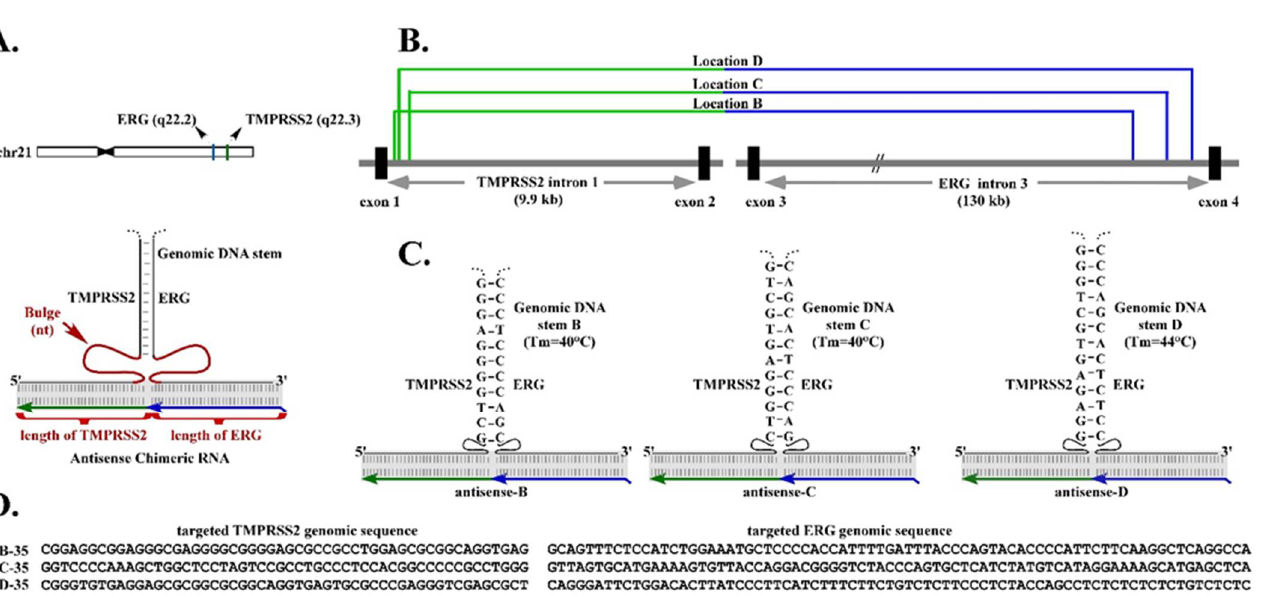
Figure 1. A model of three-way junction formation in RNA-mediated TMPRSS2-ERG gene fusion. ( A ) Upper panel: chromosomal locations of TMPRSS2 and ERG genes. Both TMPRSS2 and ERG genes are on the minus strand of chromosome 21, separated by 3 Mb, an intra-chromosomal configuration prone to rearrangements. Lower panel: schematic illustration of a three-way junction formed between genomic DNA and chimeric RNA. The three-way junction model consists of the RNA/DNA duplex and the intergenic DNA stem formed by the genomic TMPRSS2 sequence complementary to the genomic ERG sequence. Our study highlights the effects of two essential elements in the proposed three-way junction: (1) the unpaired bulges linking between the RNA/DNA duplex and the intergenic DNA stem and (2) the chimeric RNA length for forming the RNA/DNA duplex. Both elements are shown in red. ( B ) Three independent target locations used in our previous study where the designer chimeric RNAs are known to induce TMPRSS2-ERG gene fusion. As these locations are in the introns, the designed chimeric RNAs targeting them contain only intronic sequences and no exonic sequences. ( C ) The putative three-way junction formed between the targeted genomic DNA locations (black) and the designed antisense chimeric RNAs (green/blue). An intergenic DNA stem can occur when the TMPRSS2 sequence is complementary to the ERG sequence near the junction site. The intergenic DNA stem may include a high-energy G·T and A·C wobble-pair known to have Watson–Crick-like geometry in a DNA double helix. ( D ) Examples of genomic sequences targeted by antisense chimeric RNA asB-35, asC-35, and as-D35. The targeted sequences contained a 75-nt ERG gene and a 52-nt TMPRSS2 gene. In these cases, a bulge of 35 nt will be created when the chimeric RNAs form an RNA/DNA duplex with the genomic sequences.